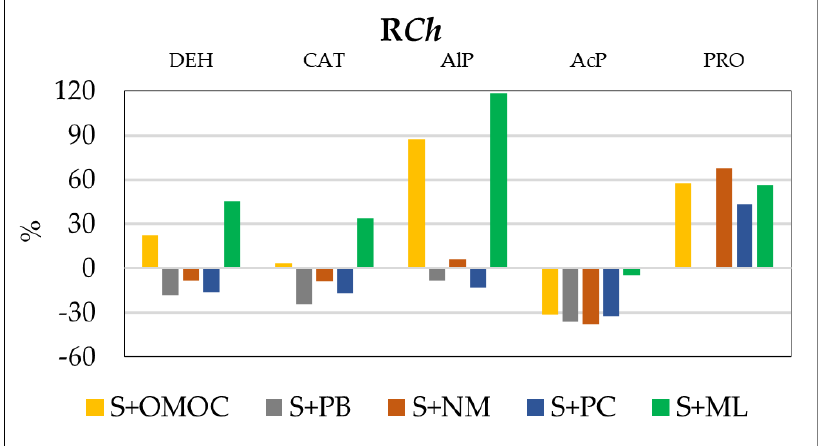
Figure 3. Percentage changes (R Ch ) in activity of dehydrogenases (DEH), catalase (CAT), alkaline phosphatase (AlP), acid phosphatase (AcP) and protease (PRO) in soil incubated with biochars.